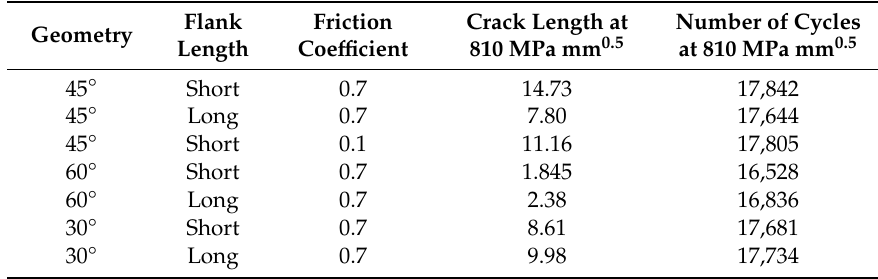
Table 8. Damage tolerant life of the analysed geometries.